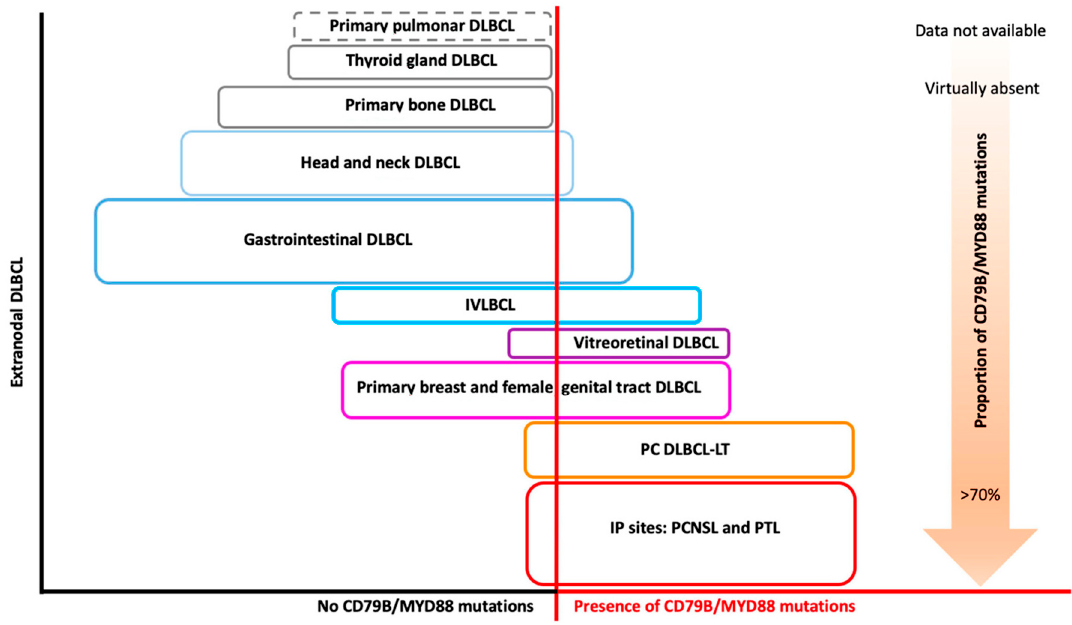
Figure 1. Extranodal DLBCL and CD79B / MYD88 mutations. Conceptual schematic representation of the prevalence of CD79B / MYD88 mutations for each type of extranodal DLBCL (see Table 1 for percentage of mutations prevalence). Each colored box has a di ff erent size, approximately corresponding to the frequency of that type of extranodal DLBCL out of the total of extranodal DLBCLs. DLBCL: di ff use large B-cell lymphoma; IP: immune-privileged; PCNSL: primary central nervous system lymphoma; PTL: primary testicular lymphoma; IVLBCL: intravascular large B-cell lymphoma; PC DLBCL-LT: primary cutaneous DLBCL-leg